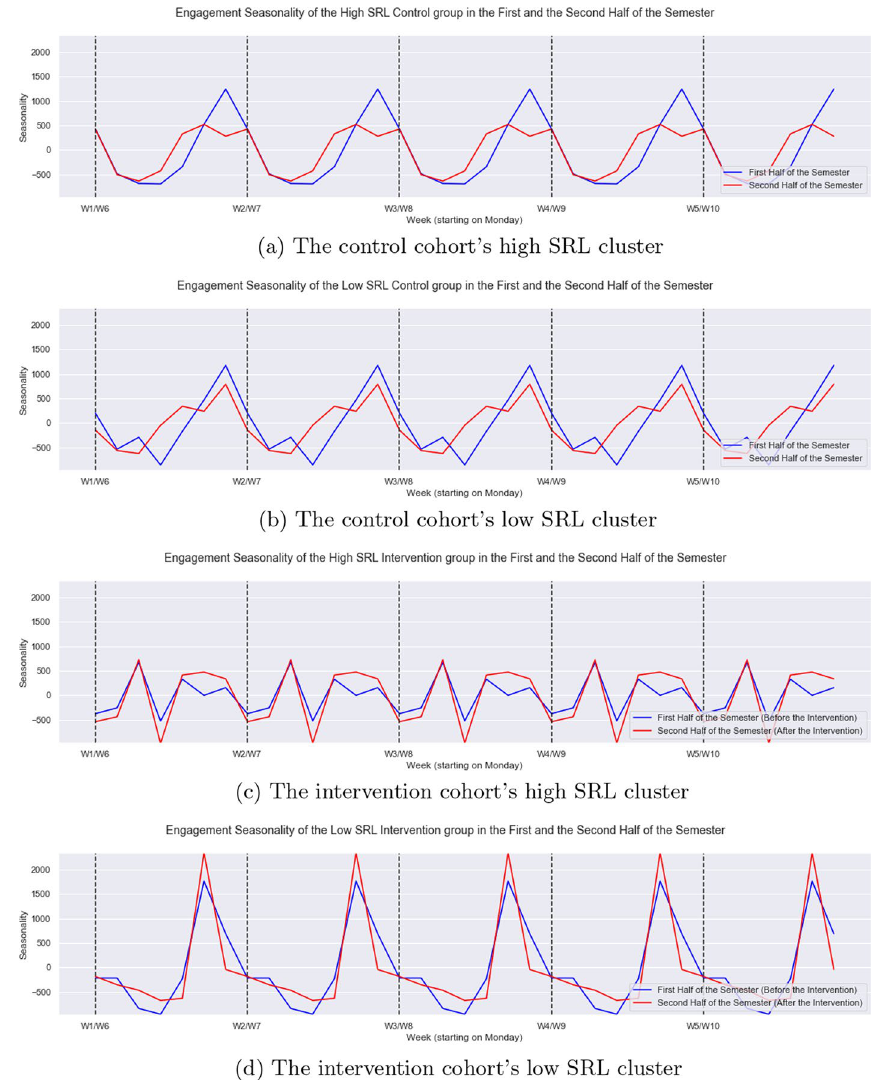
Fig. 5 Seasonal component of AvgStrCountPerDay compared the first-half (before the intervention) (blue line) and the second-half of the semester (after the intervention) (red line) among